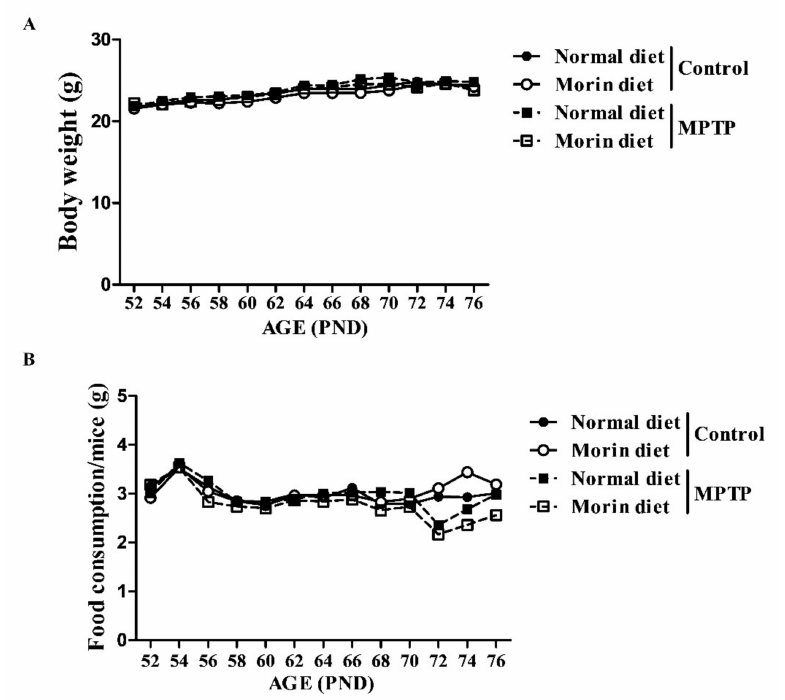
Figure 1. Body weights and food intakes in morin-fed mice. ( A ) Body weights. ( B ) Food intakes. No significant difference in body weight or food intake was observed between the control morin diet group and control normal diet group.